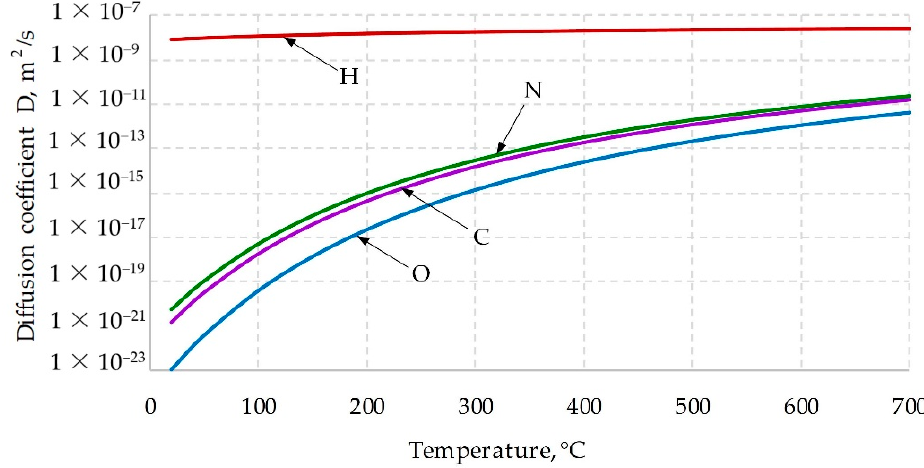
Figure 5. Dependence of diffusion coefficients for impurity atoms in α -Fe on temperature.